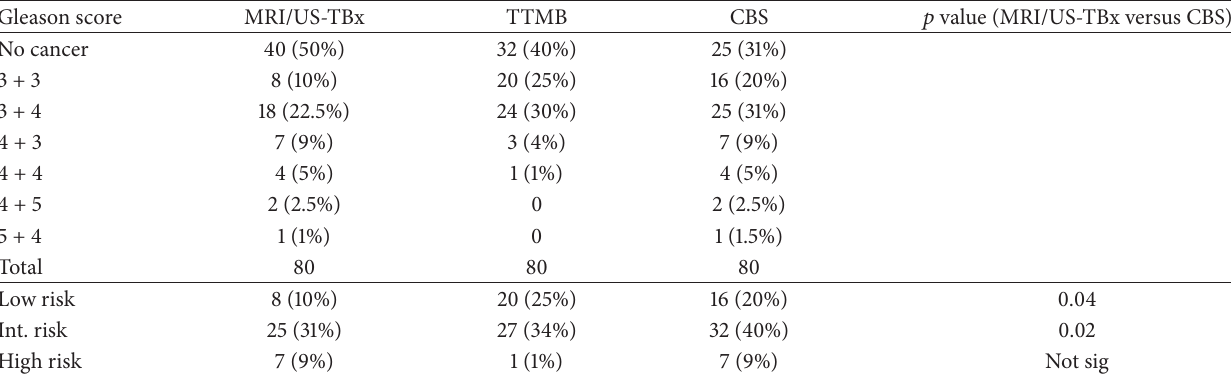
Table 5: Gleason score breakdown for MRI/US-TBx and TTMB ( 𝑛 = 80